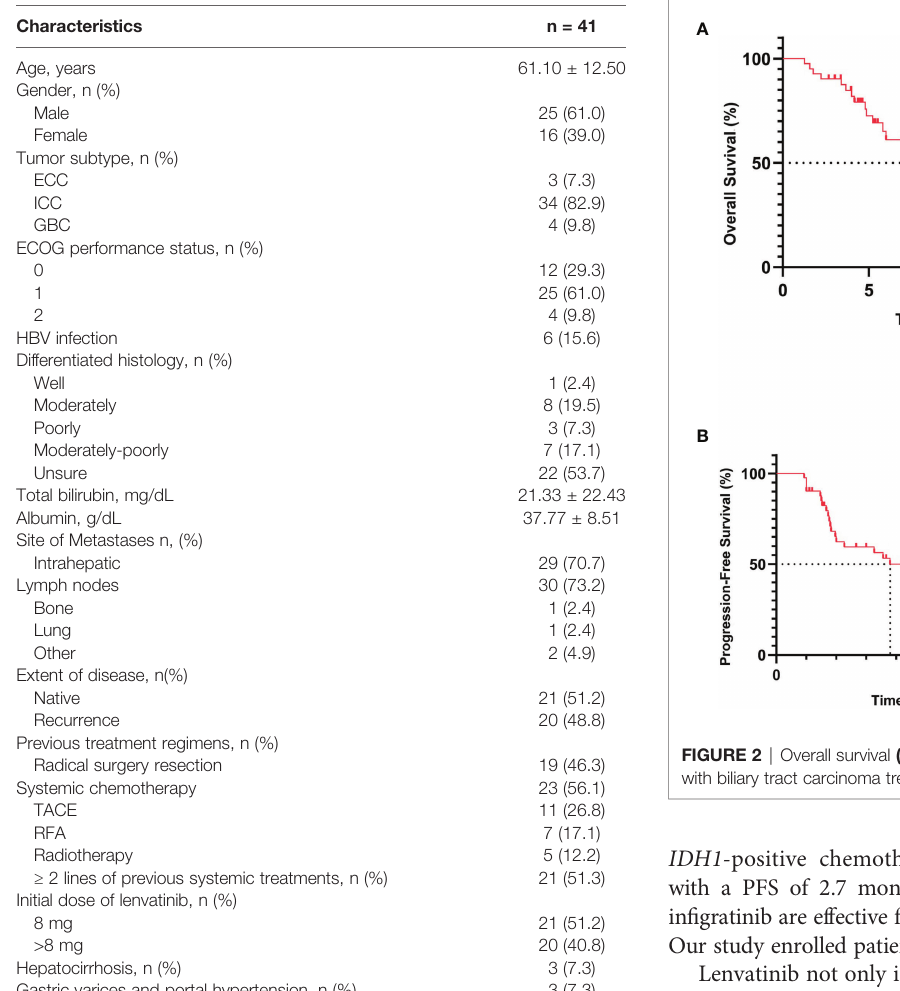
TABLE 1 | Patient demographics and baseline characteristics.